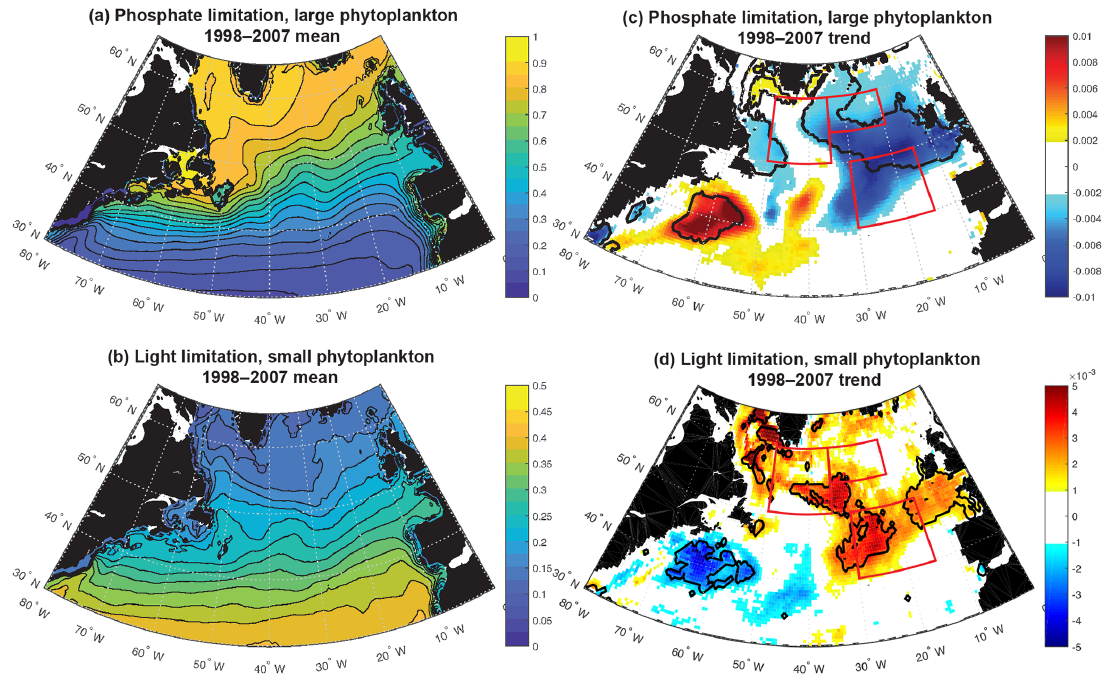
Figure 5. Terms for limitation: (a) phosphate, large phytoplankton (Eq. 3); (b) light, small phytoplankton (Eq. 2); (c) 1998–2007 trend in phosphate limitation; and (d) 1998–2007 trend in light limitation. All are unitless. In (c) and (d) , significant trends are marked with a black contour and the three focus regions are outlined in